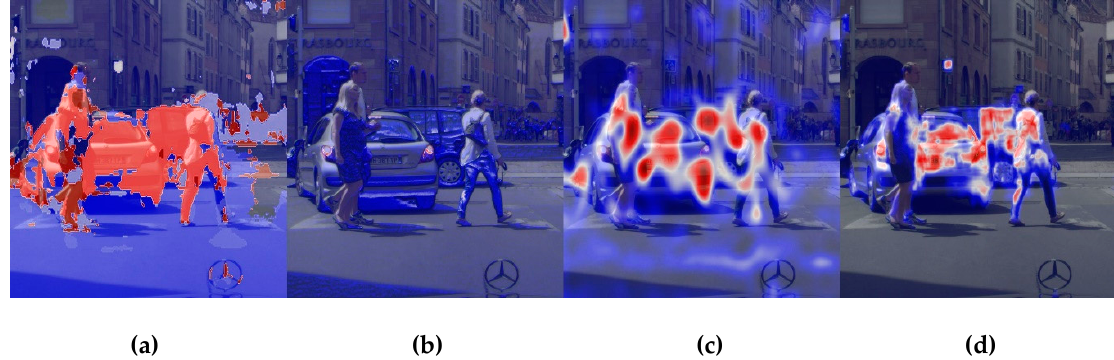
Figure 8. Grad ‐ CAM visualizations for class ‘car’ on different layers of a model: ( a ) segmented image, ( b ) early layer, ( c ) middle layer, ( d ) final layer.